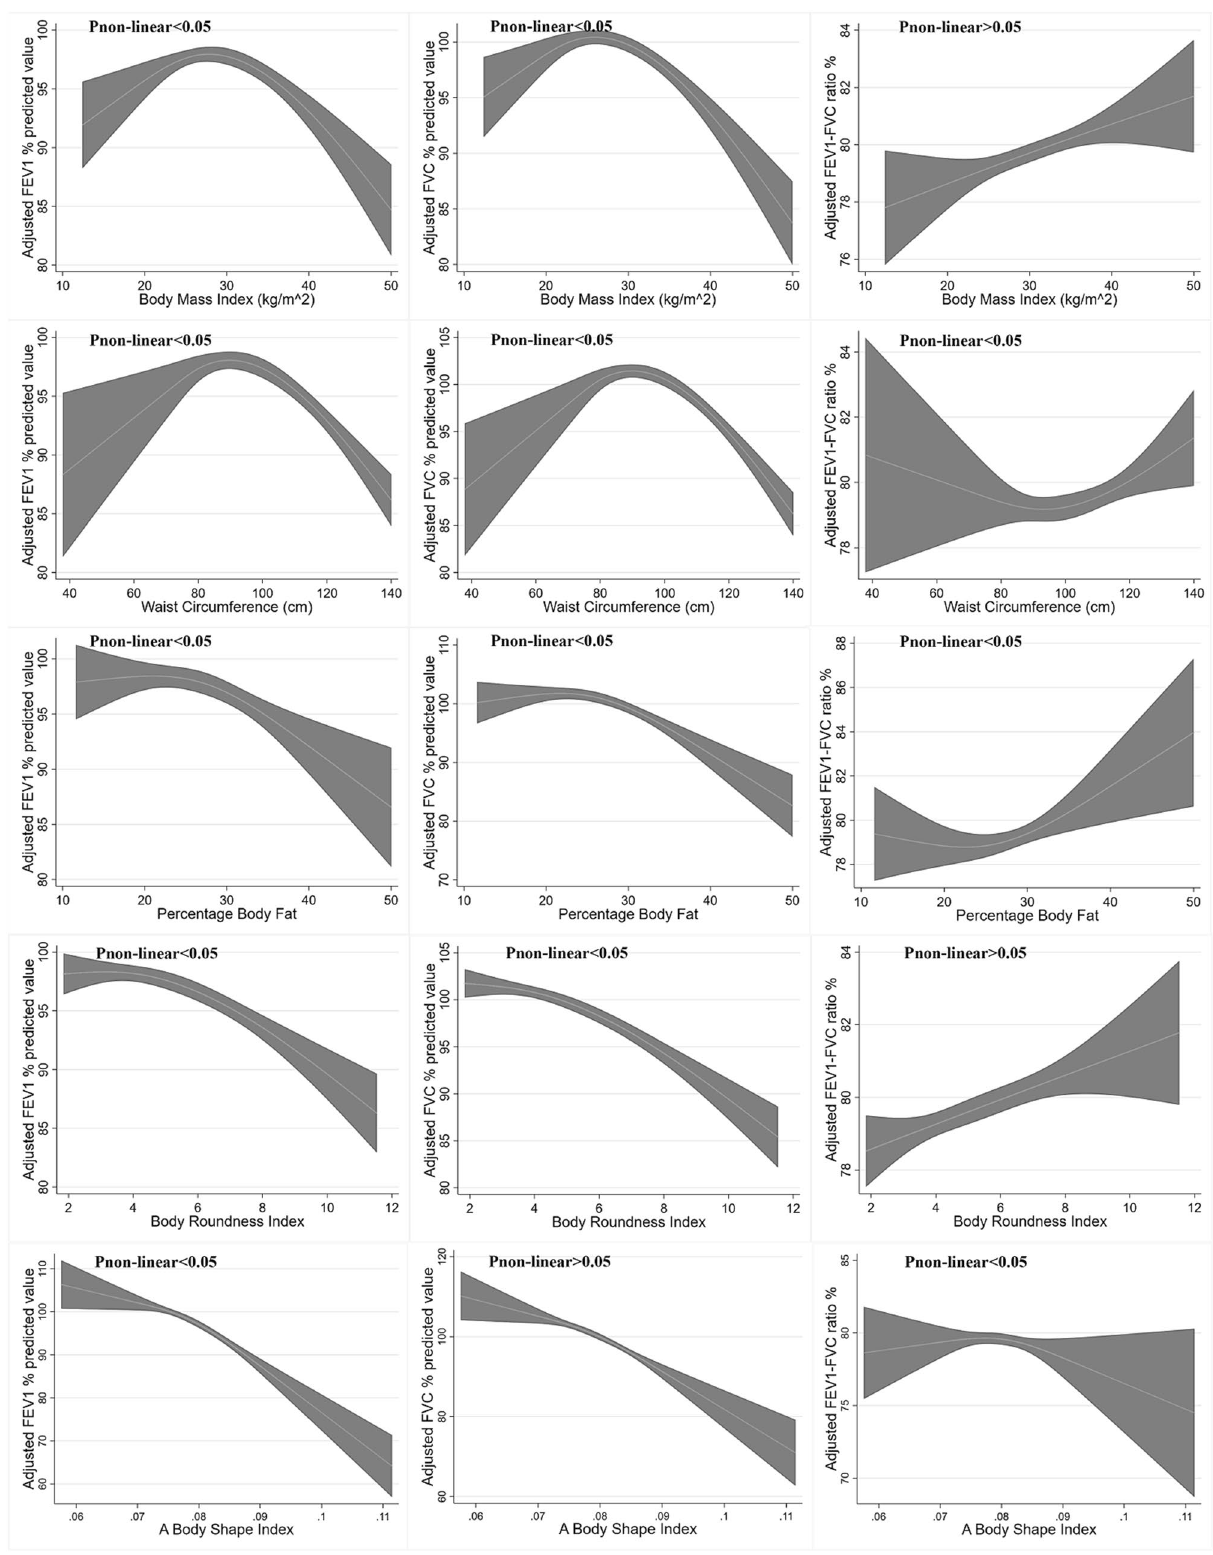
Figure 3. Reverse U-shaped association between BMI, WC, PBF, BRI, ABSI and pulmonary function in male. Data were weighted estimates. The shadow area represents a 95% confidence interval. Pi non-linear was estimated by a two-line piecewise linear model. The model was adjusted for age, race, education, smoking, physical